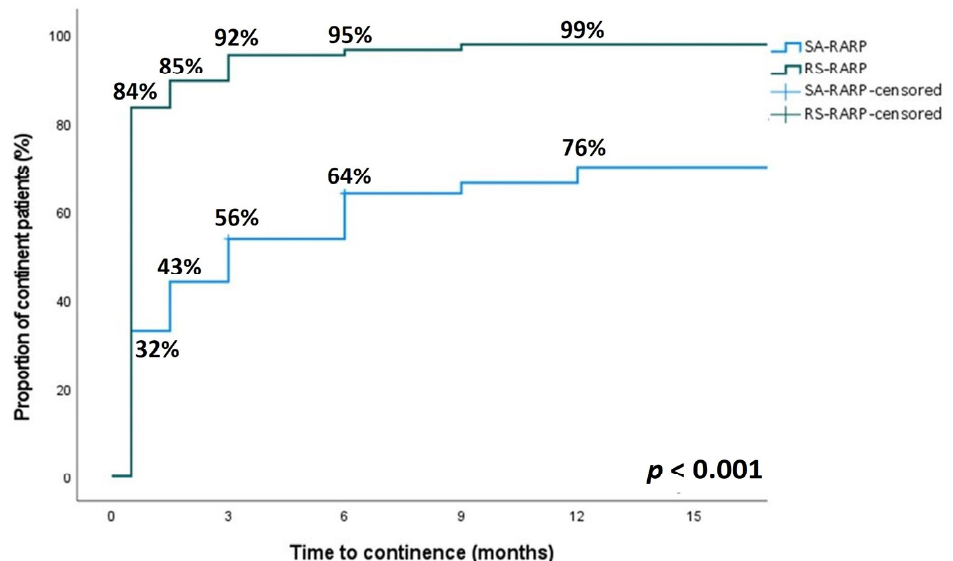
Figure 1. Comparison of the relative continence rate at 2 weeks, 6 weeks, 3 months, 6 months and 12 months after surgery after RS-RARP (green line) and SA-RARP (blue line). A significant differ-